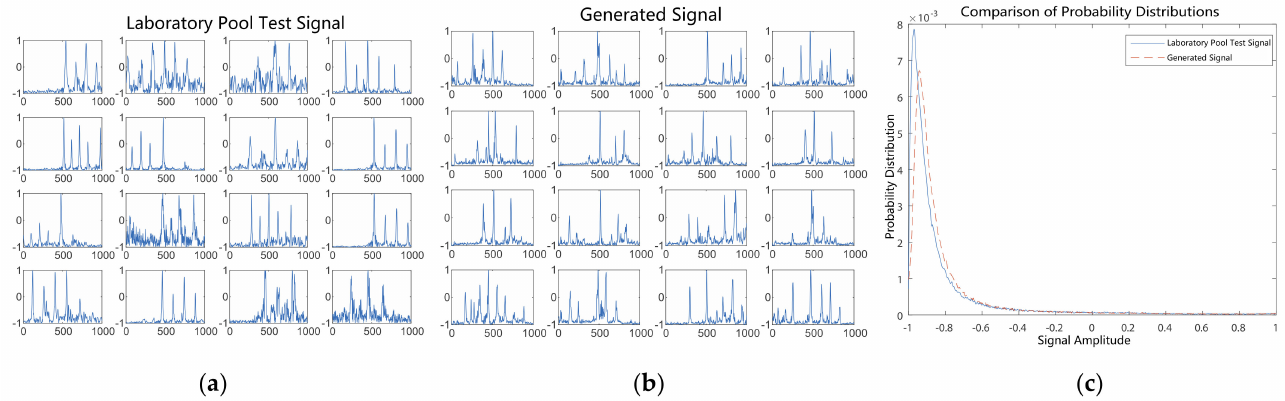
Figure 14. Comparison of generated signals with pool test signals after 250 epochs of